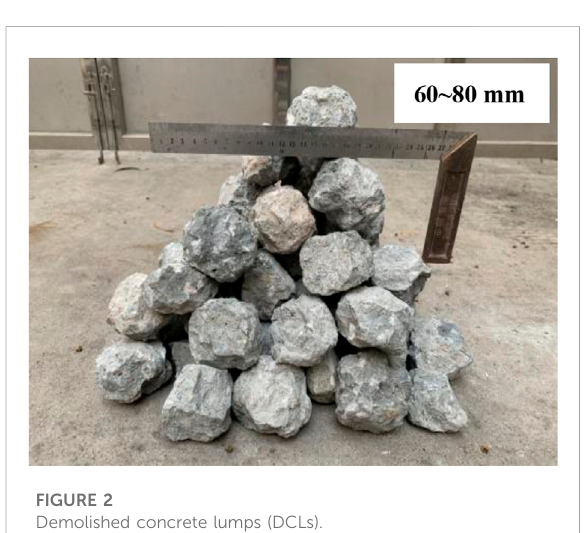
FIGURE 2 Demolished concrete lumps